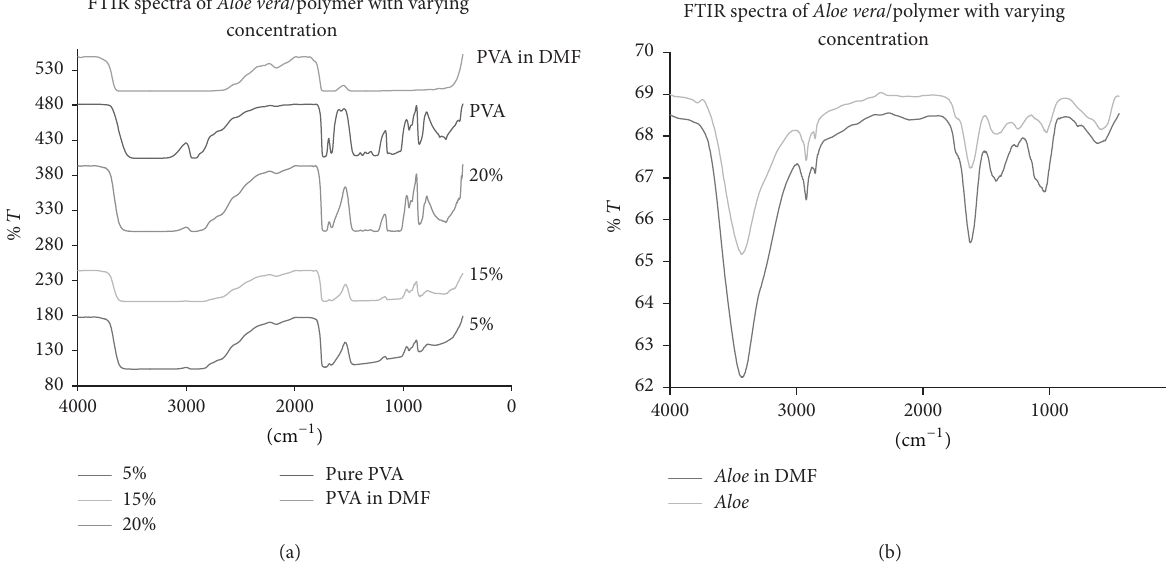
Figure 2: FTIR results of (a) PVA film and Aloe vera /polymer films with 5%, 15%, and 20% and (b) results of pure Aloe and Aloe incubated in